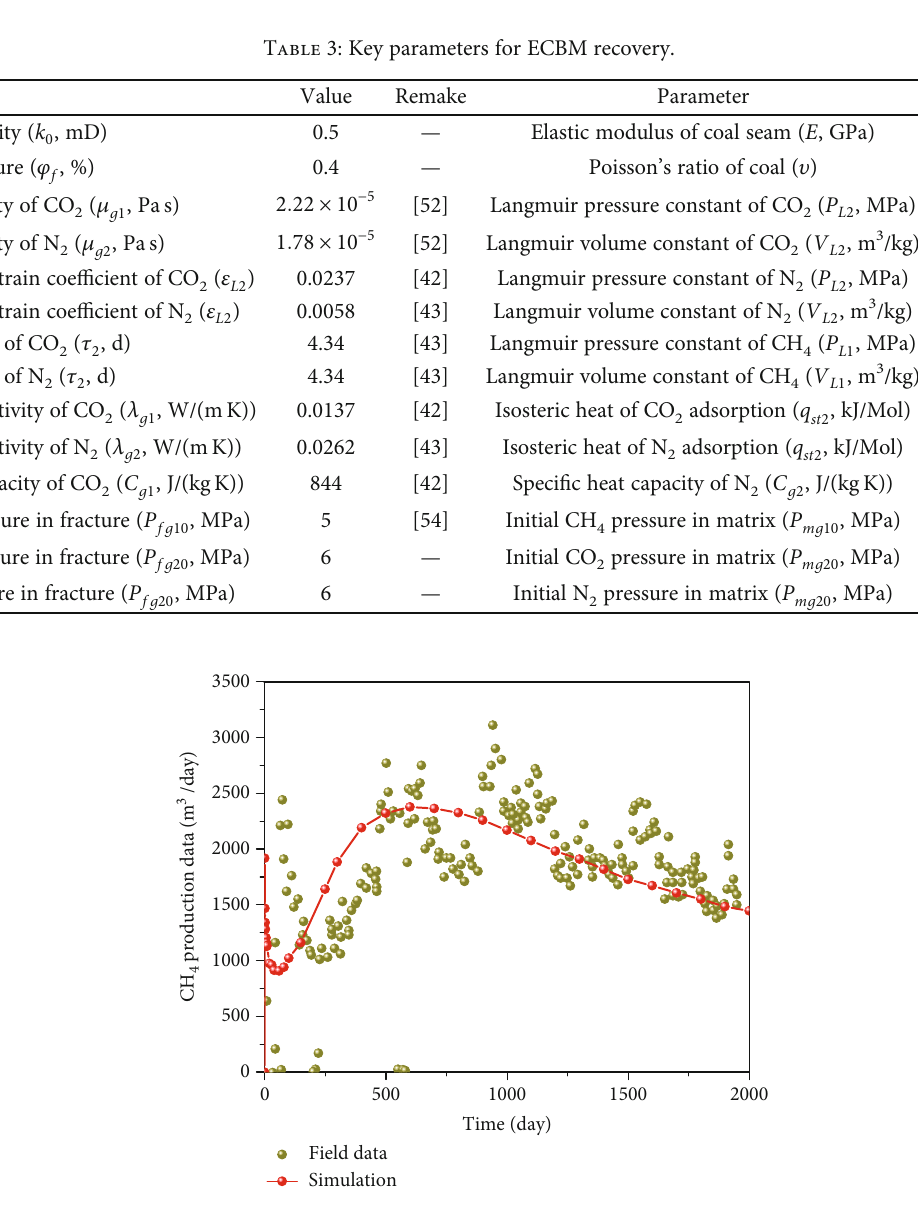
Figure 5: History matching for pressure deletion production in Qinshui Basin ( fi eld data from